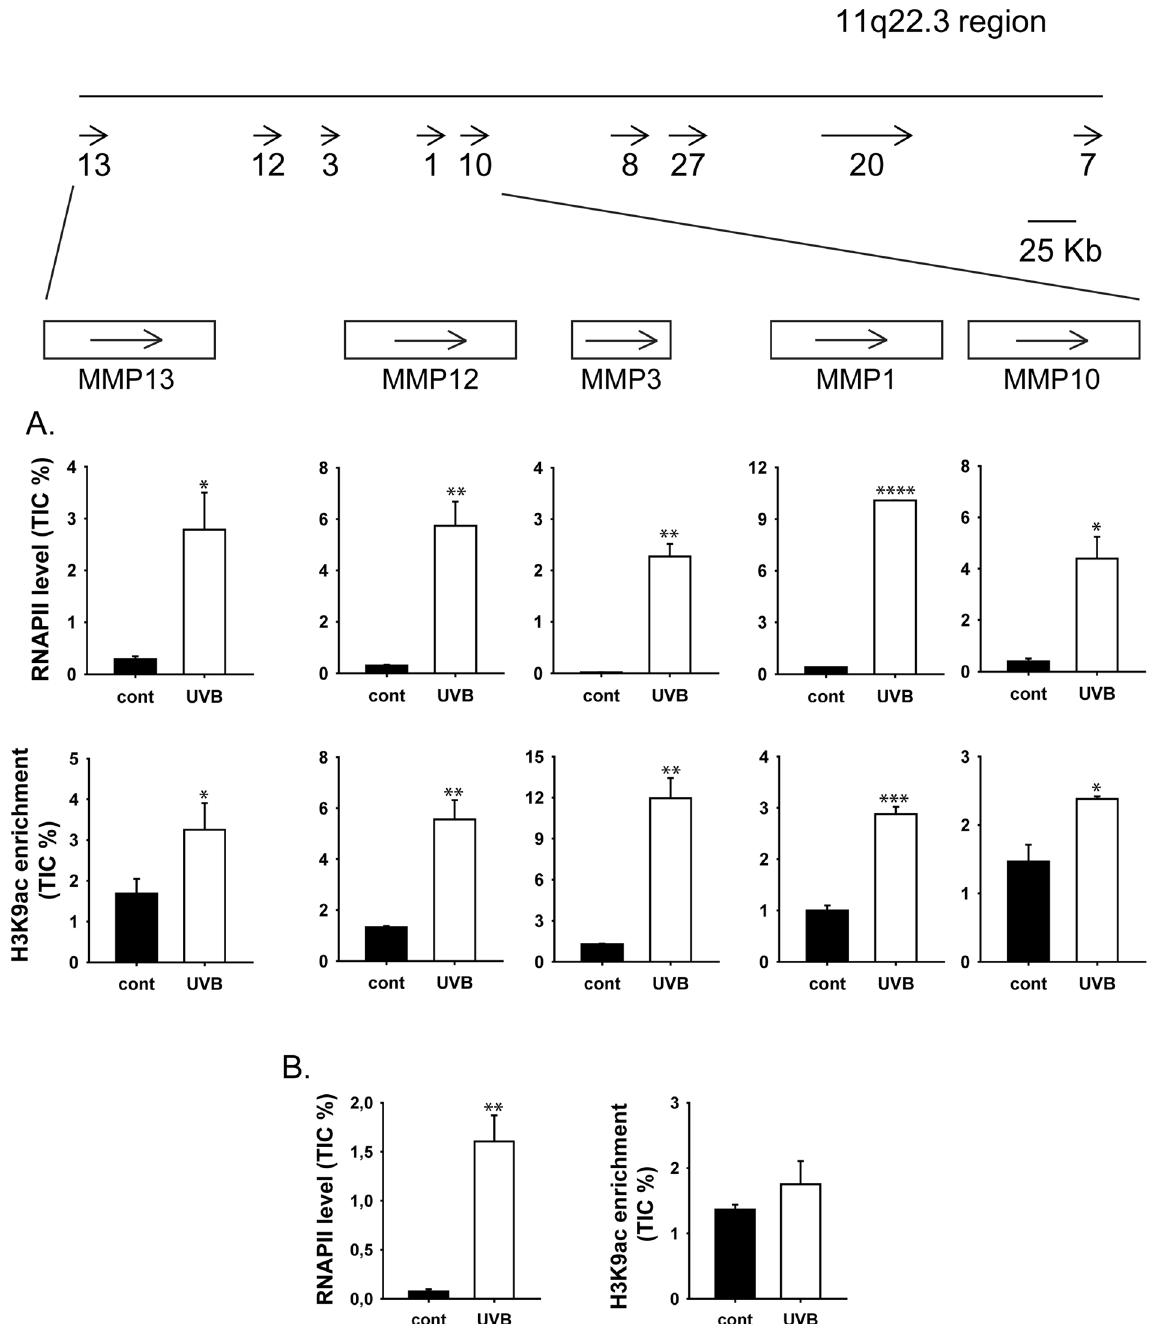
Figure 4. Recruitment of RNAPII and acetylated H3K9 on transcription initiation sites of MMP genes in human keratinocytes. HKerE6SFM cells were exposed to 80 mJ/cm 2 of UVB irradiation or mock treated. Chromatin was prepared from each sample 24 hours after the treatment. Antibodies against RNAPII, H3 and acetylated H3K9 were used for the immunoprecipitation. Precipitated chromatin samples were analysed by qPCR. Enrichments of RNAPII, H3 and acetylated H3K9 were calculated as % of total inputs and normalized to the H3 content of control samples. The means, standard deviations and significance levels based on three independent experimental triplicates are indicated. Star indicates statistical significance between the dataset (paired Anova * P < 0.05, ** P < 0.01, *** P < 0.001, **** P < 0.0001). ( A ) RNAPII and H3K9ac enrichments in transcription initiation sites of MMP genes encoded by the 11q22.3 genomic region. ( B ) RNAPII and H3K9ac enrichments of MMP9 negative control